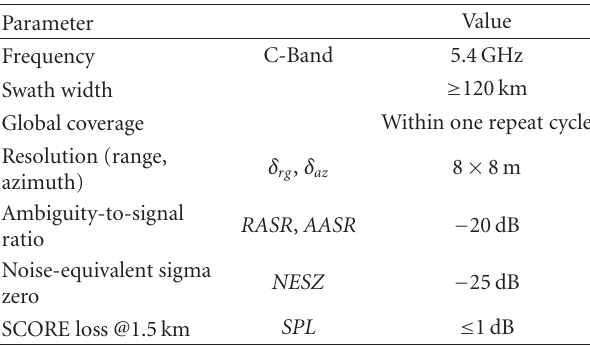
Table 1: Requirement on performance